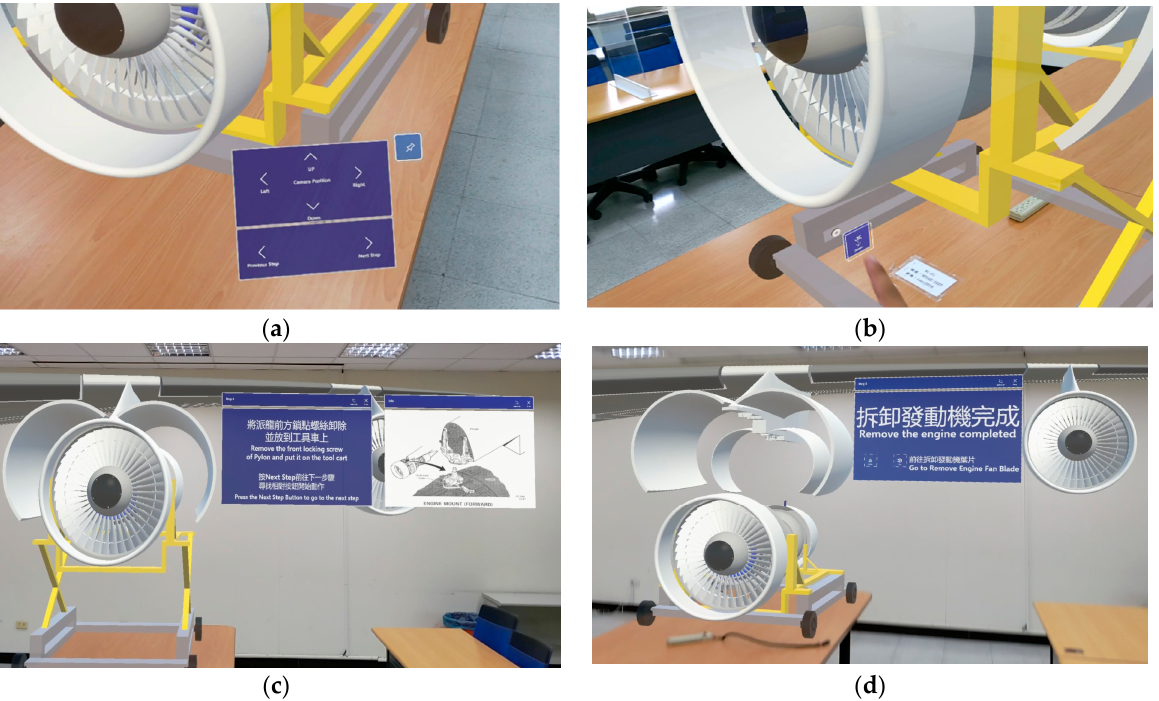
Figure 4. Remove the engine from the wing pylon scene: ( a ) The position of the view menu; ( b ) The engine cowling button; ( c ) Information of the JT9D engine and pylon; ( d ) The enigne placed on the shipping stand.